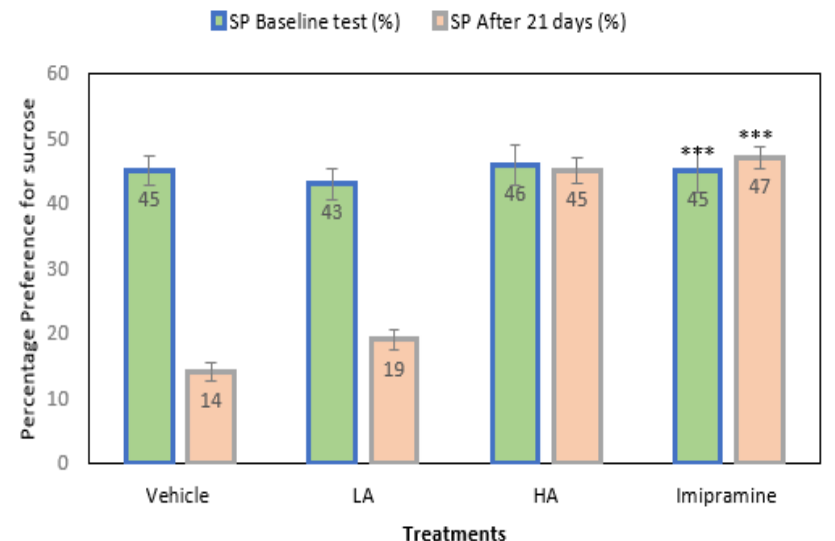
Figure 2. The effect of apigenin and imipramine on percentage sucrose preference. Data are expressed in mean ± SEM (n = 8). Data were evaluated using a one-way analysis of variance (ANOVA) and Tukey ’ s test. *** p < 0.001 when compared to the vehicle control group. LA: low dose of Apigenin (25 mg/kg); HA: high dose of Apigenin (50 mg/kg); Imipramine: standard antidepressant (15 mg/kg); Vehicle; 0.2% carboxy methyl cellulose (CMC).